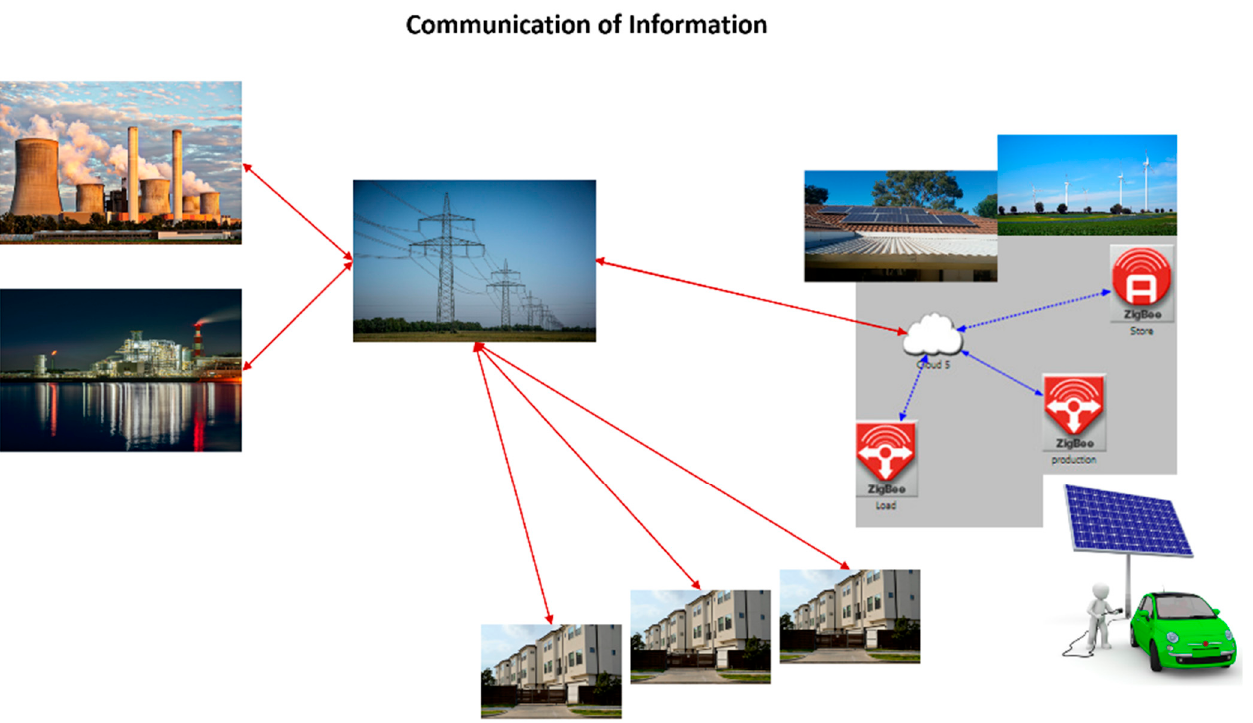
Figure 2. Communication of Information in Smart Grid.